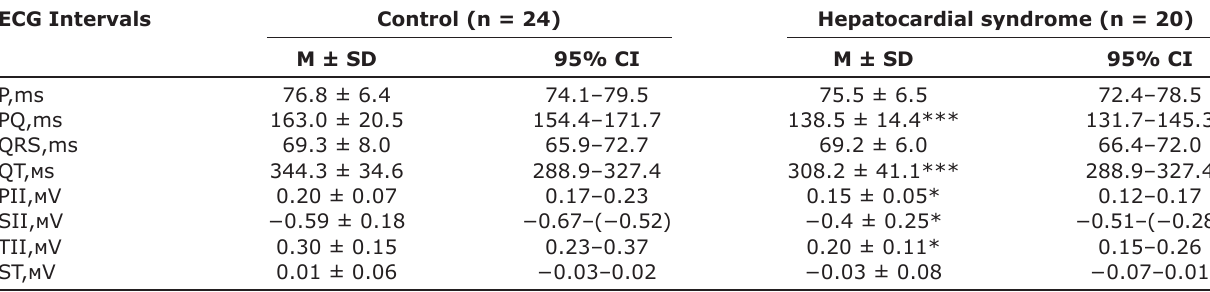
Table-2: Electrocardiographic parameters in cows with hepatocardial syndrome. ECG